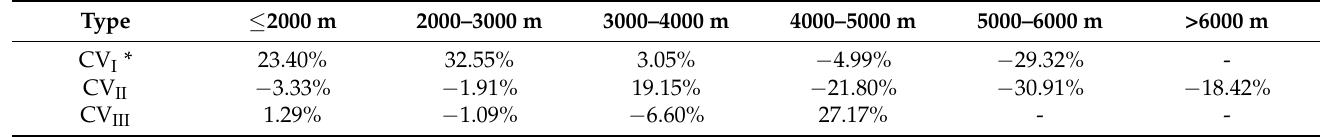
Table 2. Variation of CV with different elevation.